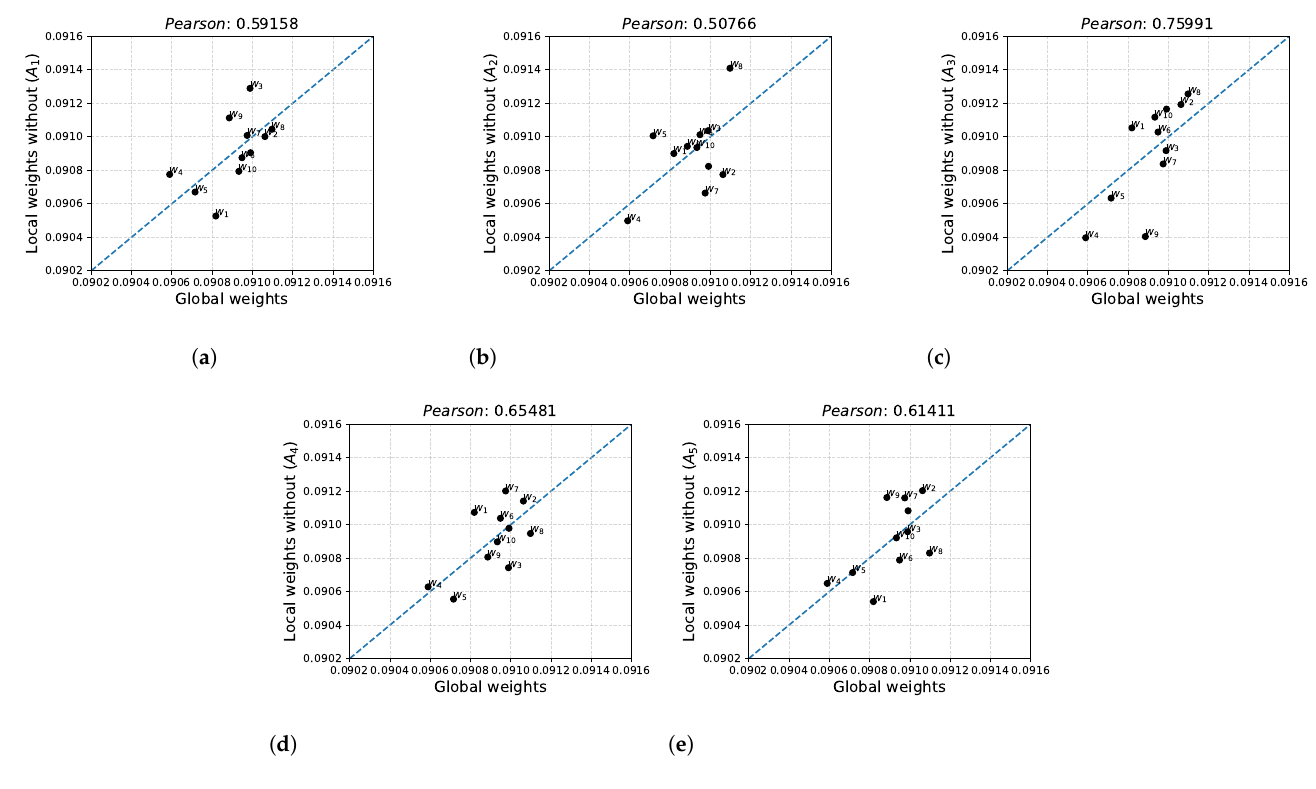
Figure 3. Global weights relative to local weights formed on the sets at the inclusions of alterna- tives A 1 – A 5 . ( a ) Without the alternative A 1 ; ( b ) Without the alternative A 2 ; ( c ) Without the alternative A 3 ; ( d ) Without the alternative A 4 ; ( e ) Without the alternative A 5 (Blue line means y = x ). Table 13. Evaluations of alternatives A 1 – A 5 from the COPRAS method for a threshold value of α = 0.05 for criteria C 1 – C 11